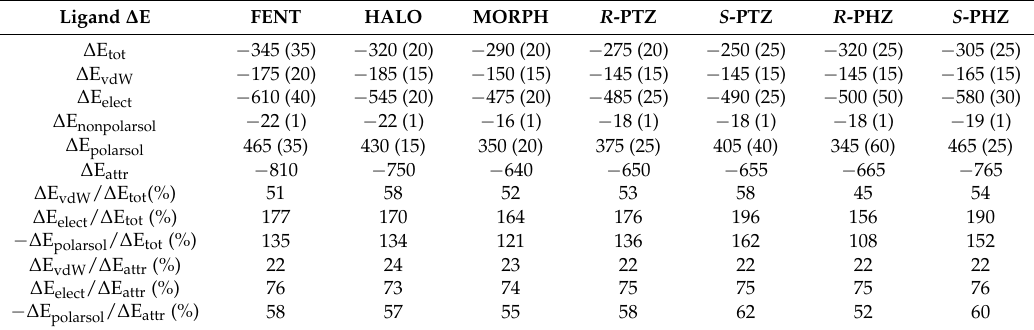
Table 1. Binding energy and its components for ligand interaction with the σ 1 receptor (kJ/mol, errors in parentheses). The ∆ E nonpolarsol term is calculated within the SASA